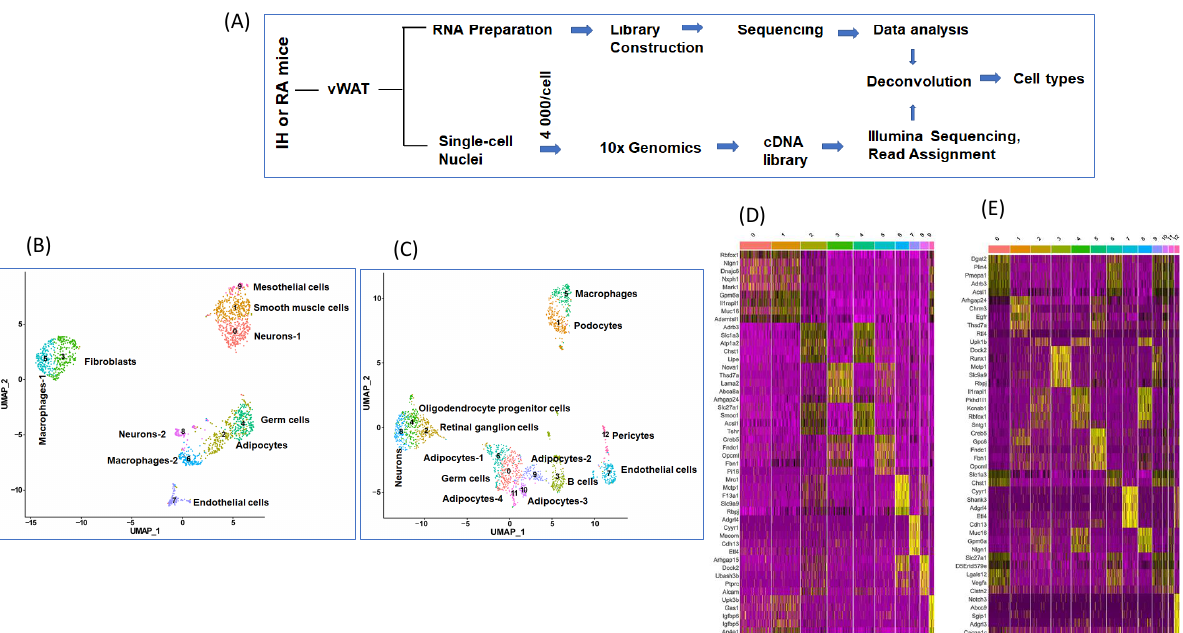
Figure 1. Single nuclei transcriptomic analysis (snRNA-seq) of murine epidydimal adipose tissues (vWAT) of mice exposed to IH or RA for 6 weeks. ( A ) Schema illustrates study design for snRNA-seq and bulk RNA-seq experiments. ( B ) Uniform manifold approximation and projection (UMAP) focuses on displaying the neighboring structure of the multidimensional manifold in few dimensions in vWAT for mice exposed to RA, n = 2. ( C ) UMAP in vWAT for mice exposed to IH, n = 2. Each dot corresponds to a single cell. ( D ) Heatmap for the 5 most enriched genes for each of the cell types in RA. ( E ) Heatmap for the 5 most enriched genes for each of the cell types in RA IH. Each cell type is represented by the top 5 genes ranked by false discovery rate (FDR) adjusted p -value of a Wilcoxon rank sum test between the average expression value for each cell type against the other average expression of the other cell types. Each column represents the average expression value for one cell type. Yellow color indicates the top 5 genes for each cell